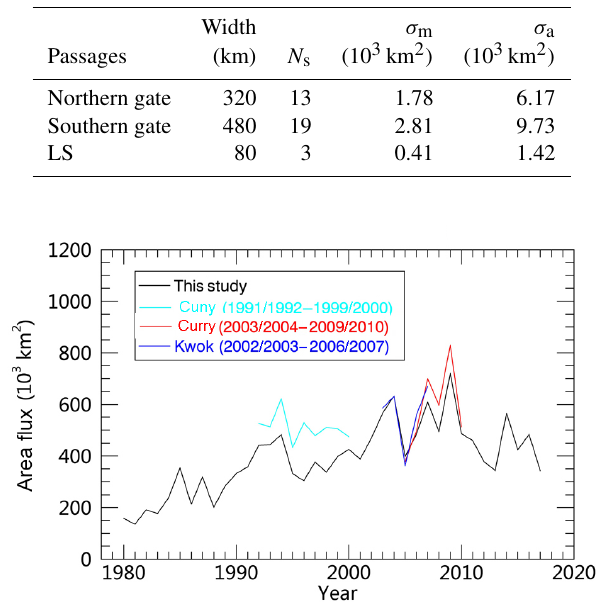
Figure 6. Comparison of sea ice area flux (November to the fol- lowing May) with estimates from Cuny et al. (2005), Curry et al. (2014), and Kwok